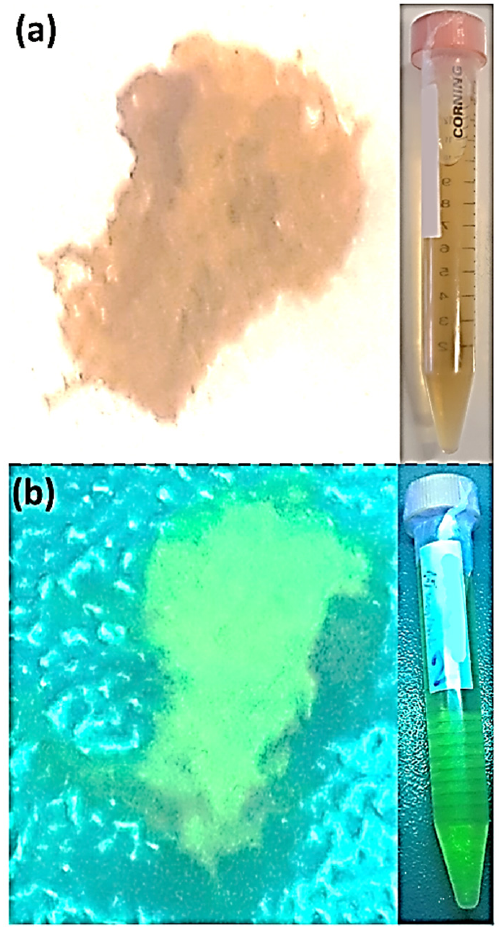
Figure 2. ( a ) Pictures of the obtained pure CNDs as a solid ( left ) and in aqueous solution ( right , falcon tube). ( b ) Pictures of the obtained pure CNDs as a solid ( left ) and in aqueous solution ( right , falcon tube) under UV light (254 nm) adapted from IEEE publisher [43].